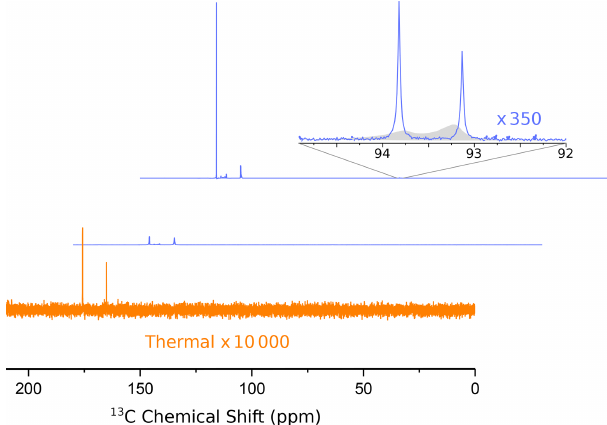
Figure 3. Hyperpolarized 13 C spectra (blue lines) of 1- 13 C pyru- vic acid. The middle and upper lines show the first two spectra, recorded 1.75 and 3.75s after the ejection of the bullet from the po- larizer, respectively. A detailed assignment of the peaks has been given in our previous publication (Kouˇril et al., 2019). The inset shows a magnified view of the doublet near 93ppm, which is due to the natural abundance carbonyl of pyruvate hydrate. The asymmetry of this doublet yields a 13 C polarization of − 22% at the (labeled) carboxyl carbon. The full width at half maximum of both peaks of the doublet is 3.2Hz. The filled gray area in the inset shows the spectra from our previous publication for comparison (where we used positive DNP leading to an inverted asymmetry). The improve- ment in resolution is obvious. Note that in our experiment the line near 94ppm is more intense since we used negative